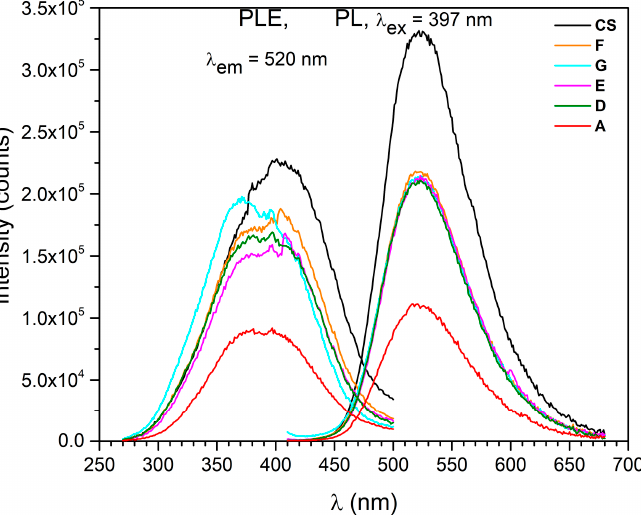
Figure 7. Excitation and emission spectra of the prepared samples by comparison to a commercial sample (CS) samples (color codes: A—red, D—green, E—magenta, F—orange, G—turquoise, CS—black).